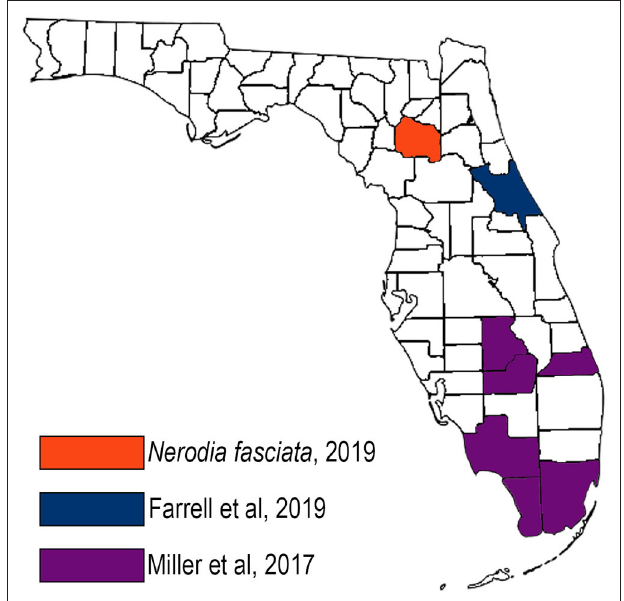
FIGURE 4 | Map of Raillietiella orientalis documentations in Florida, United States showing the northward extension of the parasite over time.